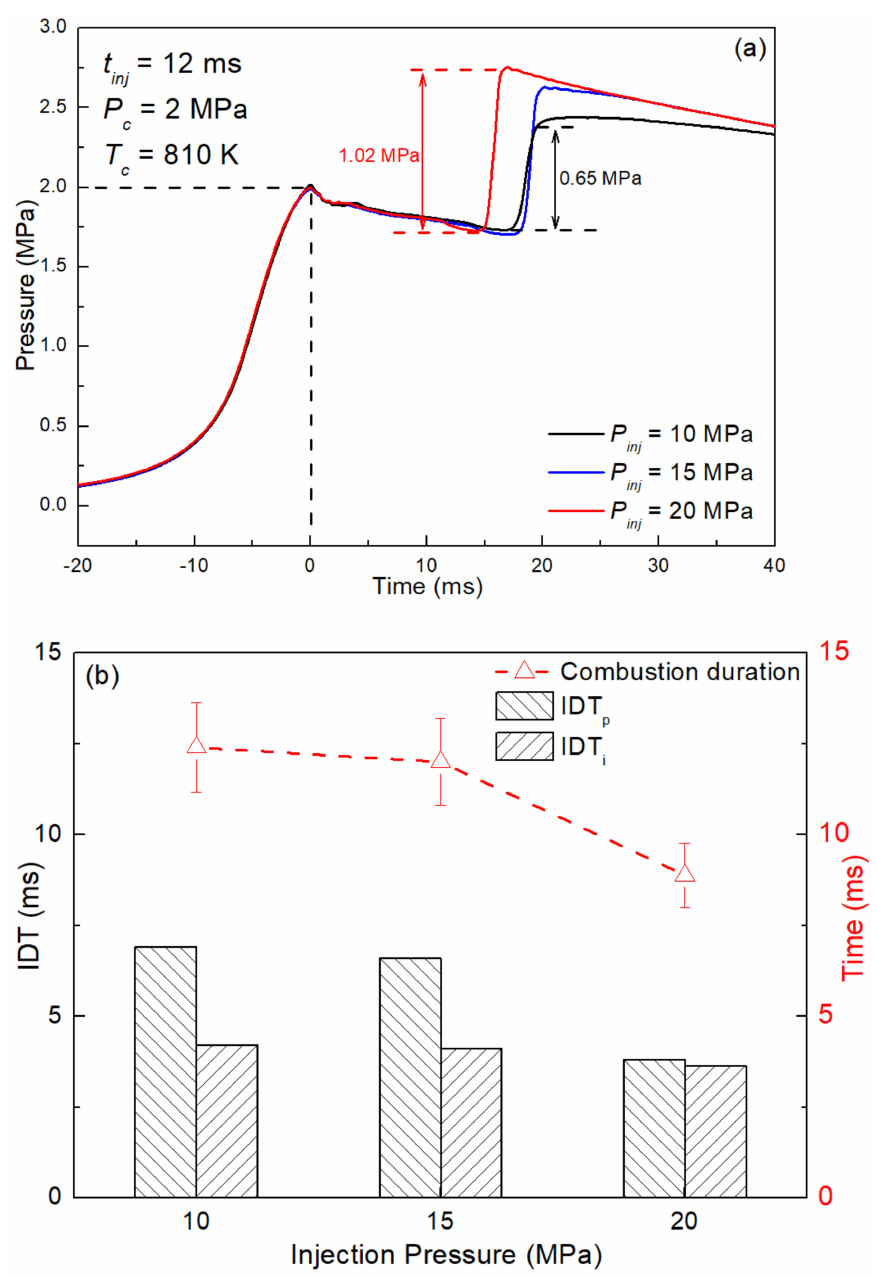
Figure 8. Effects of injection pressure on pressure history ( a ), and IDT and combustion duration ( b